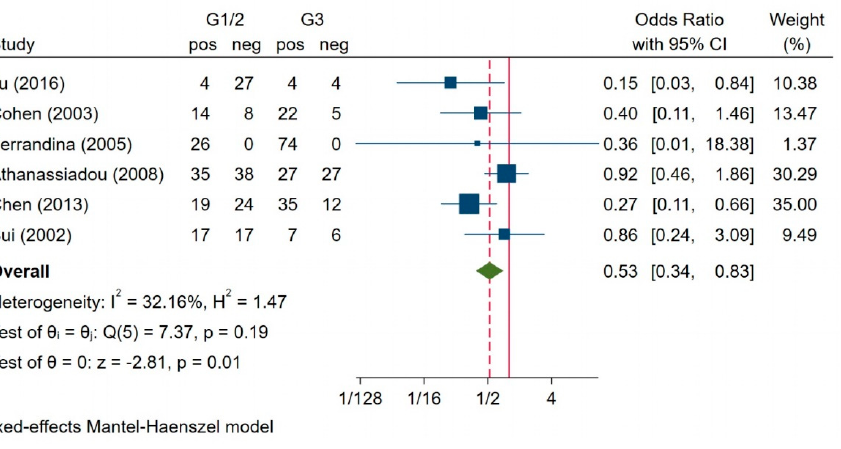
Figure 6. Association between survivin expression and histologic grade [7,21,22,24,34,38].